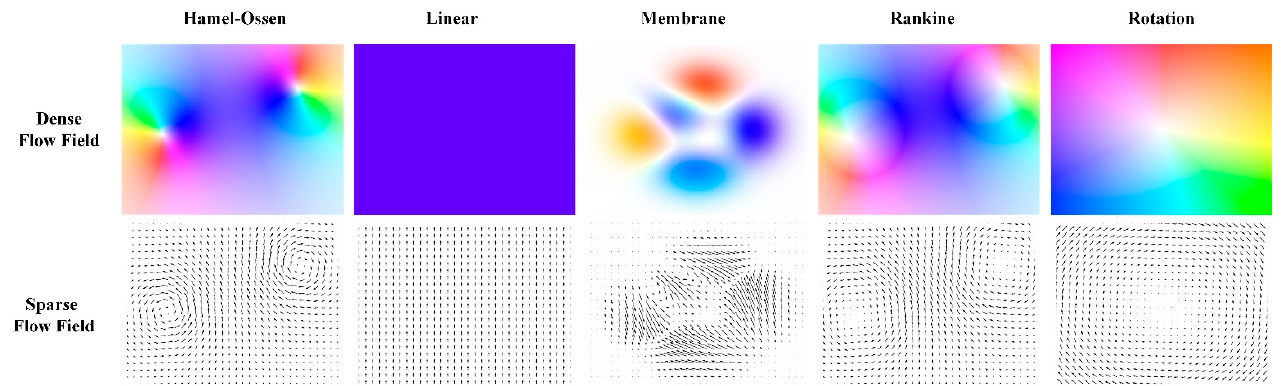
Figure 3. Schematic diagram of flow field types.